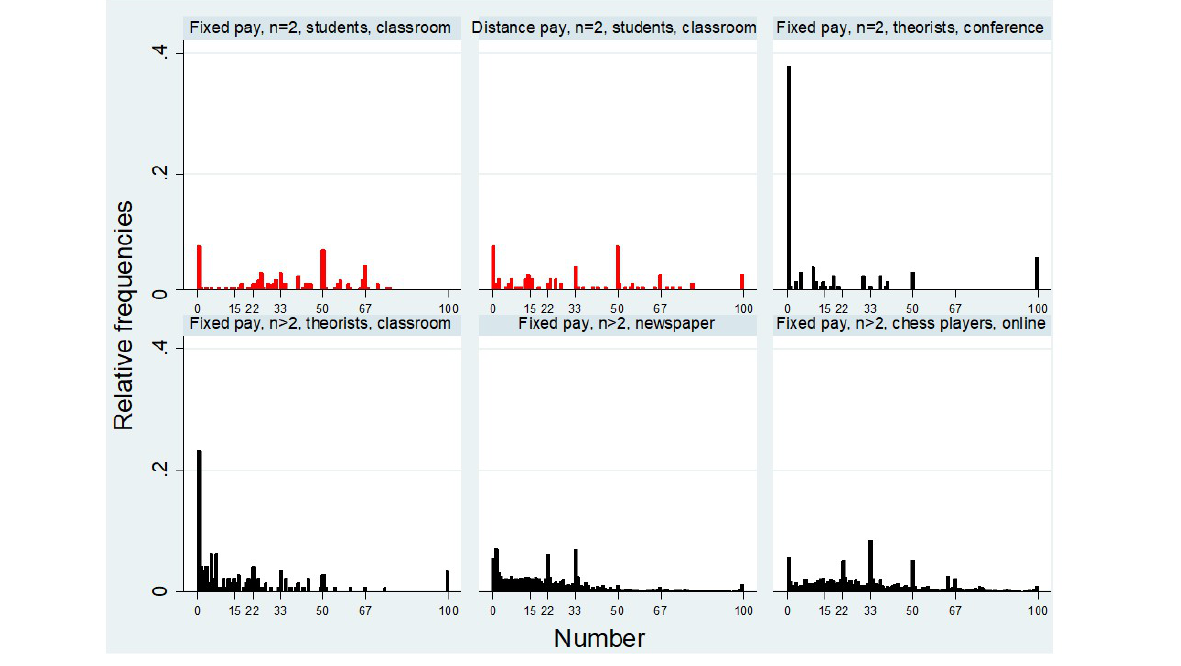
Figure 3: Relative frequencies of choices reported by Nagel et al. (2016) in the two-person games with fixed payoffs (upper left), distance payoffs (upper middle) and with economics professors in various conferences (upper right); lower left for n > 2 games with economic professors and students in advanced economic classes; in lower middle newspaper contestants; lower right chess players online. Data source: UR: Grosskopf and Nagel (2008); LL and LM: Bosch-Domenech et al.